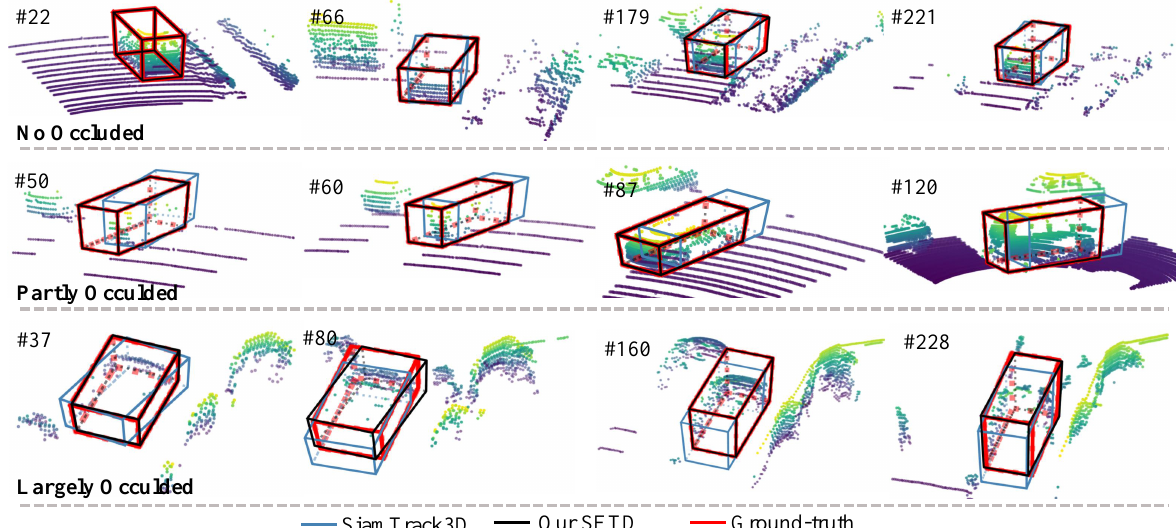
Figure 7. Visual results in terms of occlusion. The first row shows the results of a visible vehicle. The second row shows partly occluded vehicles. The last row is a largely occluded vehicle. Our SETD performed better than SiamTrack3D in all three degrees of